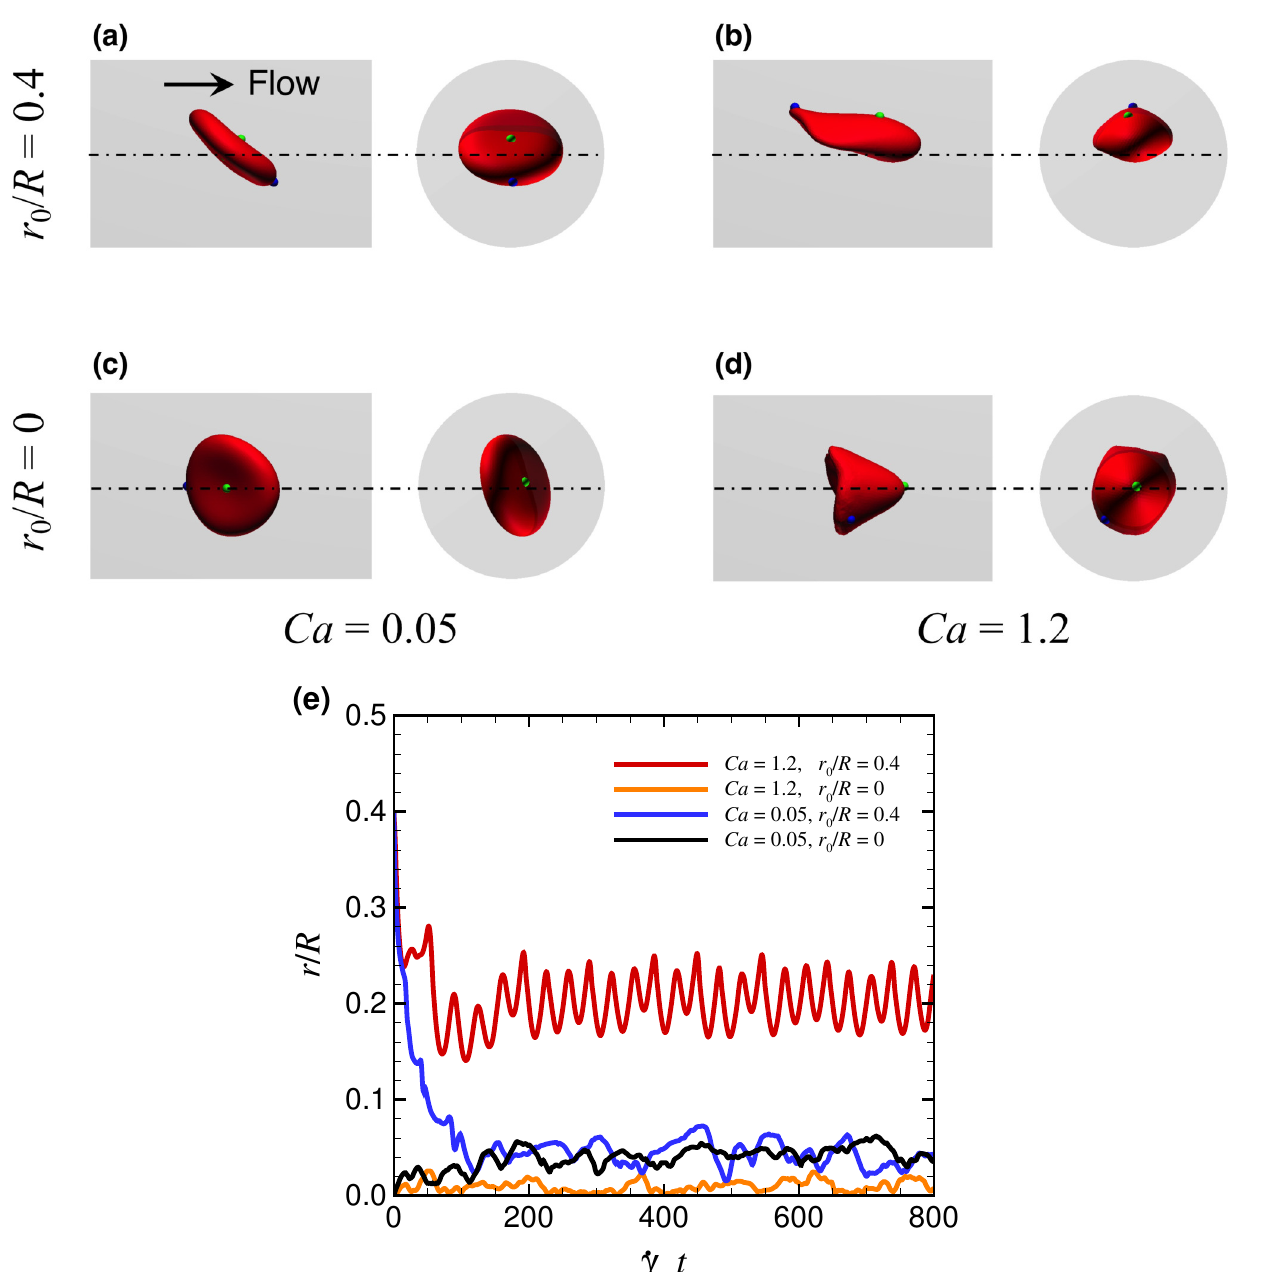
Figure 2. Snapshots of flowing RBCs in steady state ( ˙ γ m t = 800) for ( a , c ) Ca = 0.05 (see also Videos S1 and S3) and ( b , d ) Ca = 1.2 (see also Videos S2 and S4). The right side is the axial view and the left side is the lateral view; the flow direction is from left to right. For each Ca , the initial position of the RBC centroid is set to be ( c , d ) r 0 / R = 0 and ( a , b ) r 0 / R = 0.4. ( e ) Time history of the radial position of the RBC centroid r / R for different Ca and r 0 / R . The results were obtained with λ =